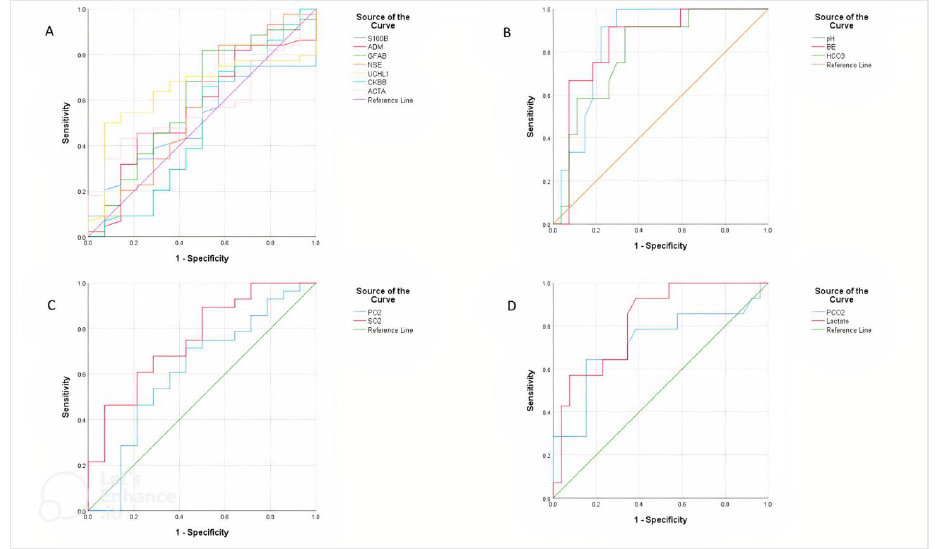
Figure 2. Receiver operating characteristic curve (ROC) analysis for the differentiation between the survivor and non-survivor calves with asphyxia based on the serum brain-related biomarkers ( A ), pH, BE, HCO 3 ( B ), PaO 2 , SO 2 ( C ), and PaCO 2 , lactate ( D )